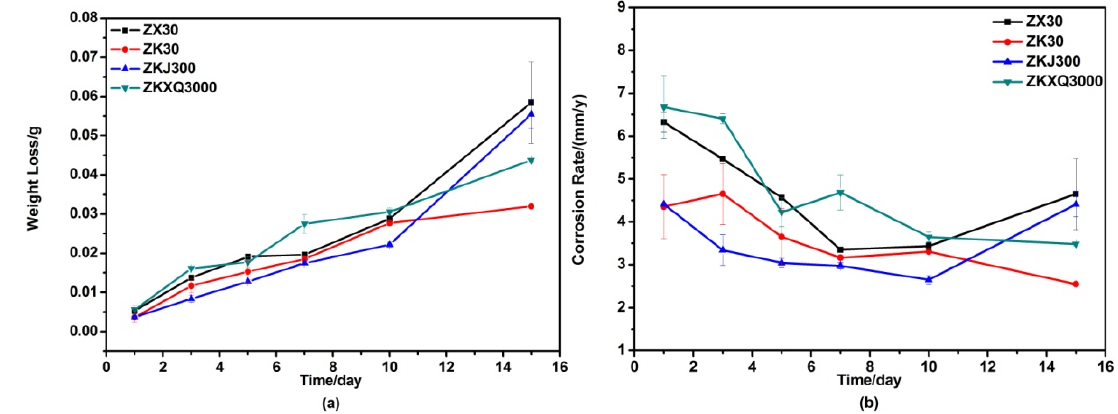
Figure 9. Weight loss ( a ) and corrosion rate ( b ) curves of the as ‐ extruded ZX30, ZK30, ZKJ300 and ZKXQ3000 alloys immersed in SBF for different days.